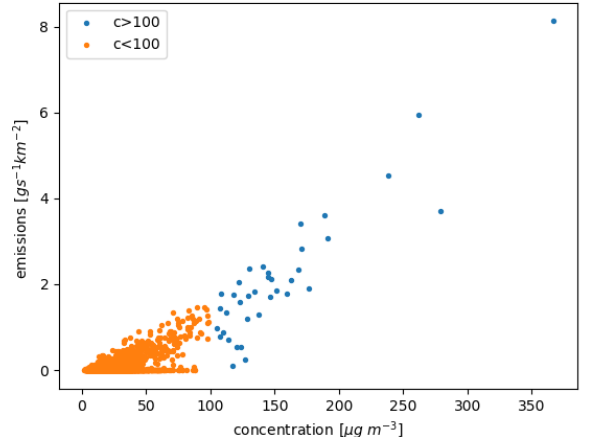
Figure 20. Scatter plot of the daily mean CAMx concentrations of PM 10 corresponding to Prague city centre vs. WBD emissions of coarse PM (CCRS) from the 90km × 90km area around Prague for the 2007–2016 period. Orange/blue circles stand for concentrations below/above 100µgm − 3